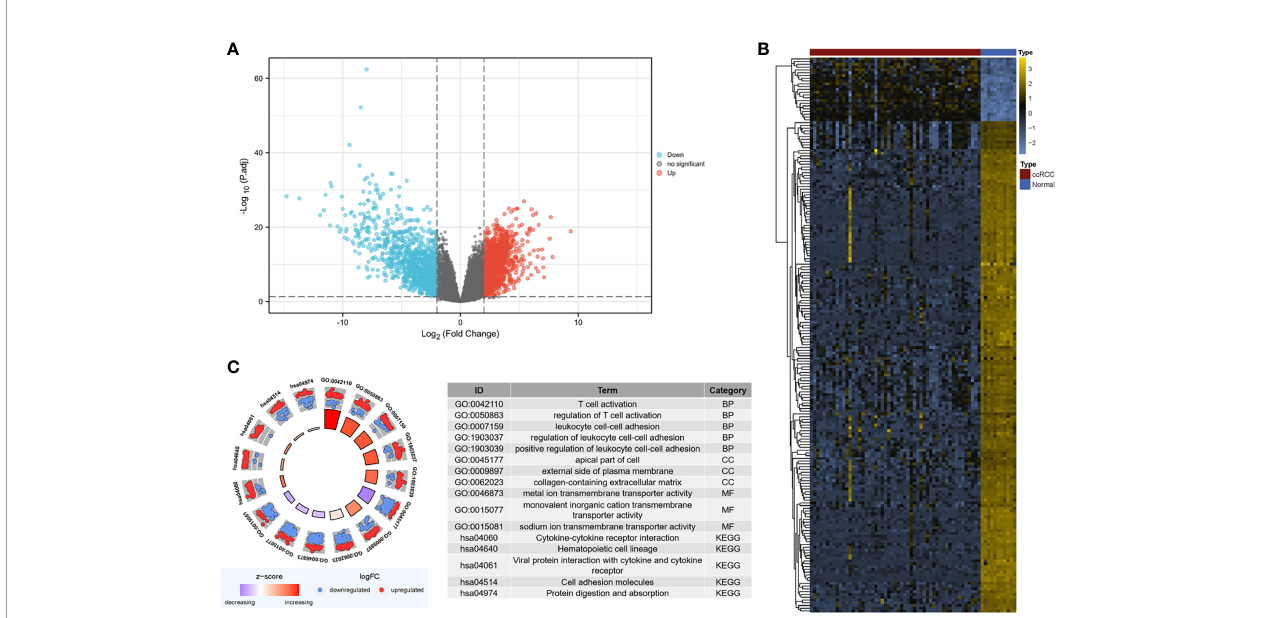
FIGURE 2 | Screening for DEGs. (A) Volcano map of DEGs between ccRCC and normal samples in the GSE126964 dataset. The red plots in the volcano represent upregulated genes, and the blue points represent downregulated genes. (B) Heatmap of the 200 selected DEGs. The color in heatmaps from blue to yellow shows the progression from low expression to high expression, respectively. (C) GO and KEGG analyses of the DEGs. The outer circle shows the scatter plot of the assigned gene log 2 fold change for all terms: red points show genes that exhibited increased expression, whereas the blue points represent genes that exhibited decreased expression. The inner circle indicates the Z-score value and the number of genes. Red represents a higher z-score value, and purple represents a lower Z-score value. DEG, differentially expressed gene; BP, biological process; CC, cell component; MF, molecular function; GO, Gene Ontology; KEGG, Kyoto Encyclopedia of Genes and Genomes; ccRCC, clear cell renal cell